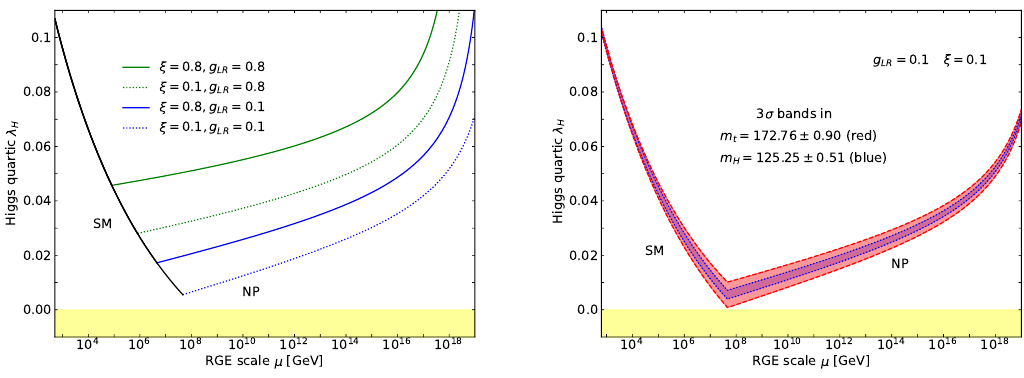
Figure 2 . Evolution of the effective Higgs boson quartic coupling λ H with the renormalization scale µ ∼ H , eqs. (4.2) and (4.3). In the first panel, the colored lines represent the RG evolutions obtained for the indicated benchmark setups. In each case, the Higgs boson quartic coupling evolves according to the SM trajectory, shown in black, until it reaches the considered colored curve, then proceeds along the latter. The value of the renormalization scale at the point where the two curves meet corresponds to the matching scale. The second panel shows the effect of the current experimental uncertainties on one of the setups analyzed in the previous panel. In both the panels, the yellow band indicates the region excluded by vacuum